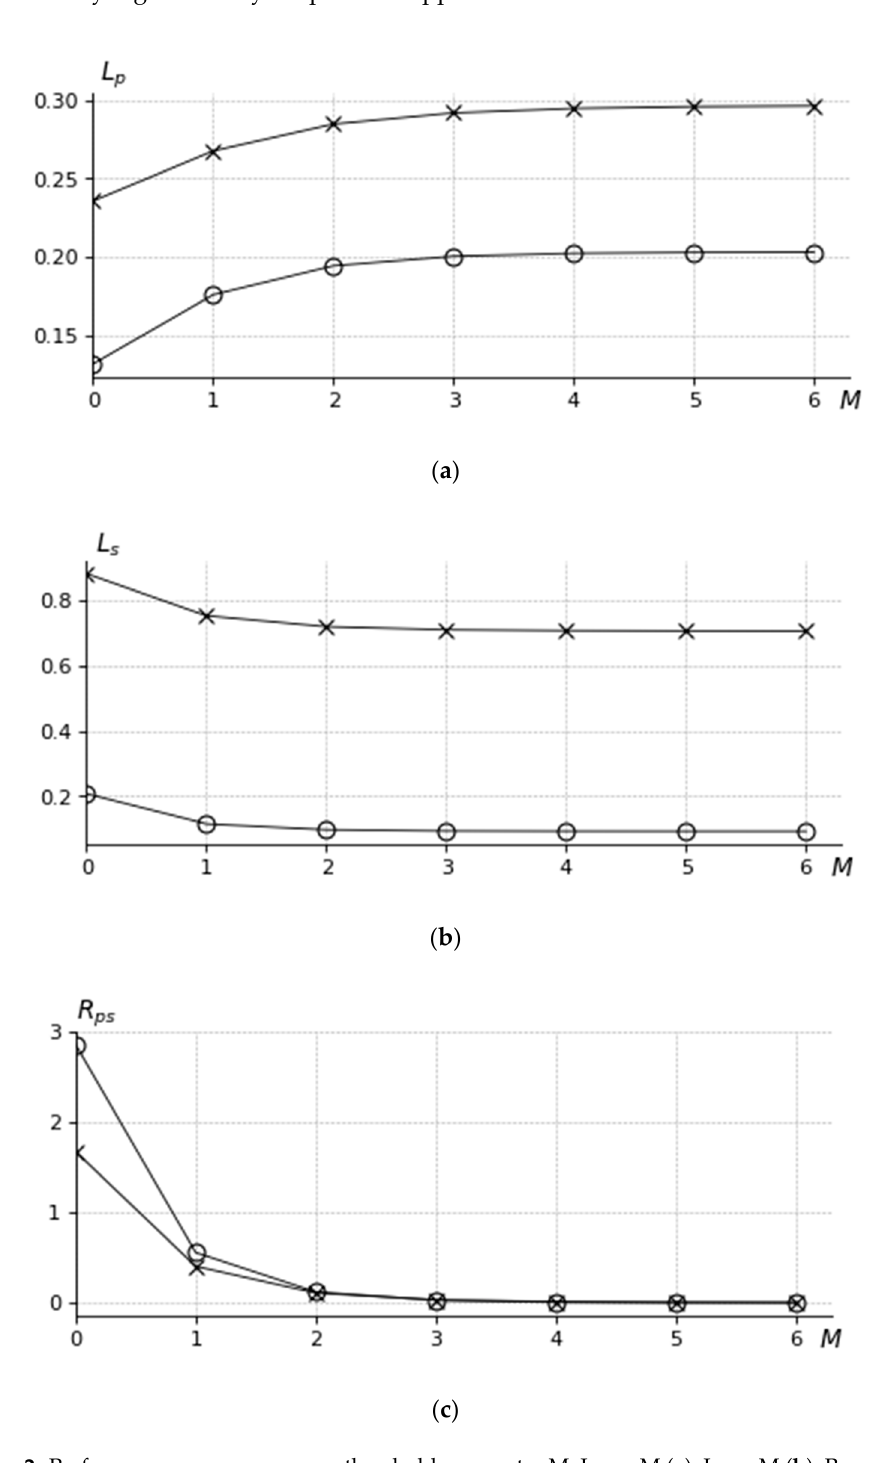
Figure 2. Performance measures versus threshold parameter M; Lp vs M ( a ), Ls vs M ( b ), Rps vs M ( c ).